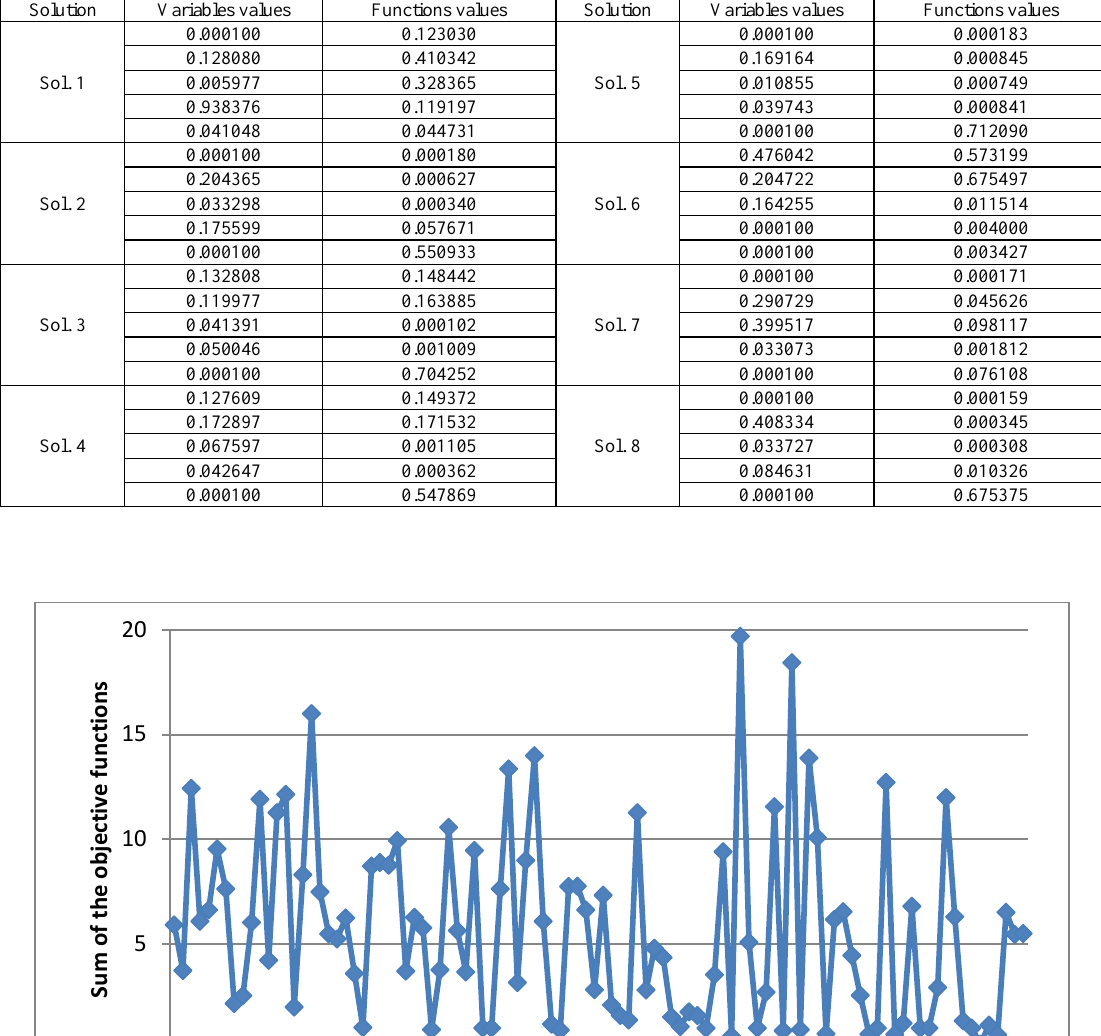
Table 7. Examples of nondominated solution obtained by MOPSO for hydrocarbon combustion problem